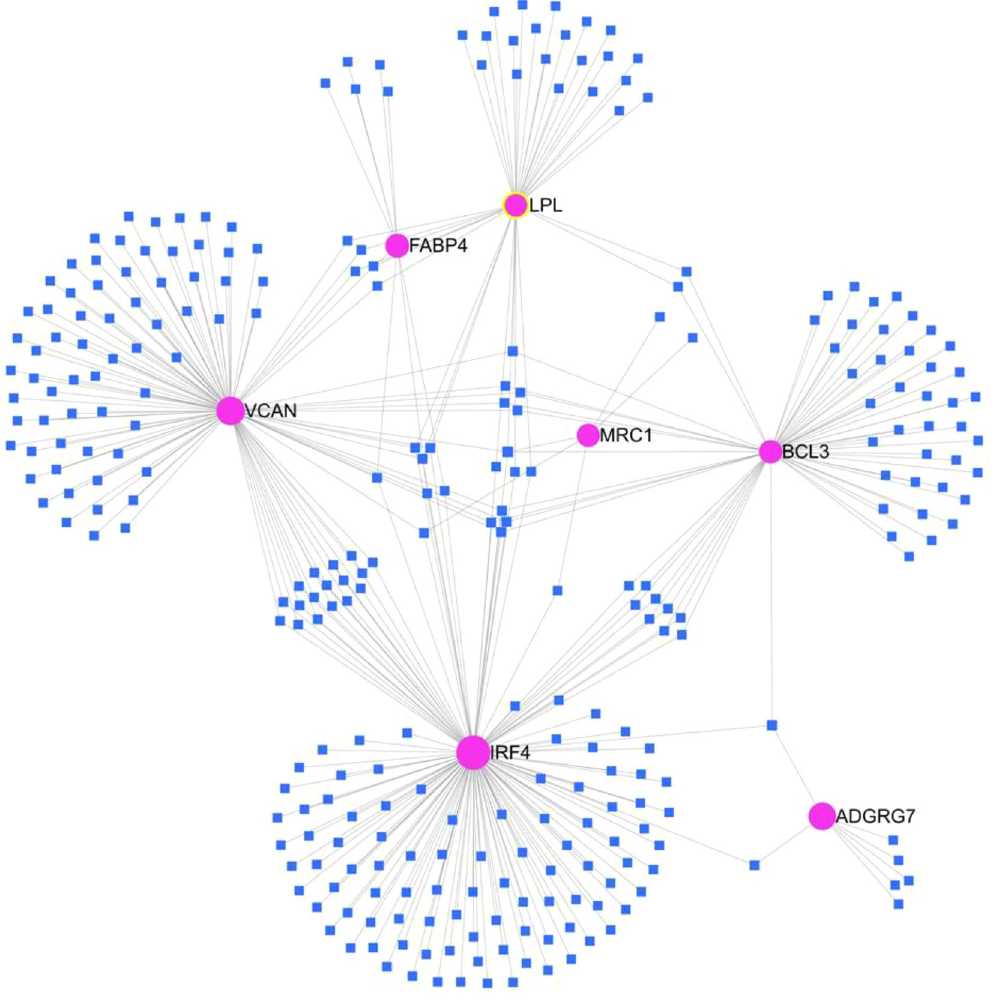
Figure 4: Network of identified miRNAs and their target genes made by miRNet 2.0. The round pink spots represent DEGs and the blue coloured squares represent the